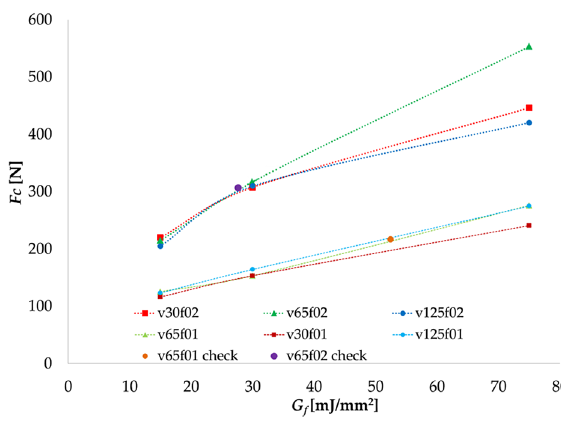
Figure 2. Cutting force evolution based on the fracture energy.